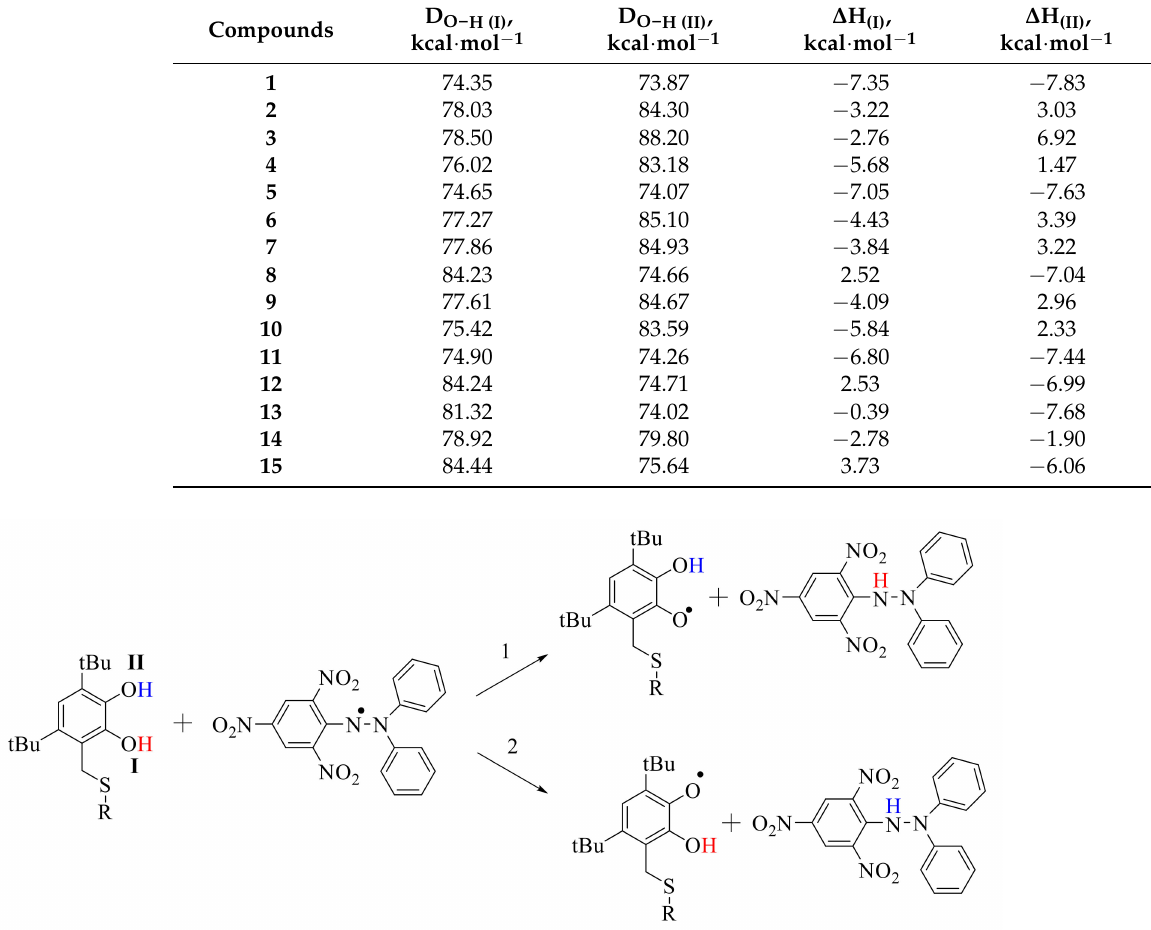
Table 2. Calculated dissociation energies of O–H (D O–H ) bonds for catechols and ∆ H of the reaction with DPPH radical (DFT, basis B3LYP/6-31++G (d, p)).